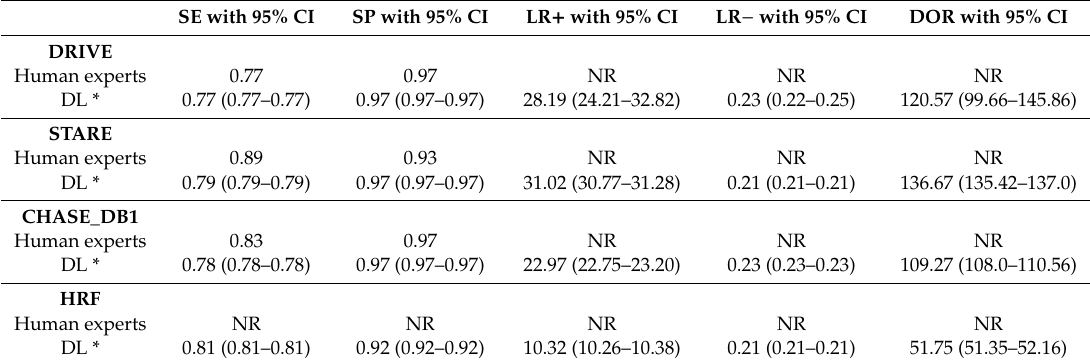
Table 3. Summary Estimates of DL performance in retinal vessel segmentation.